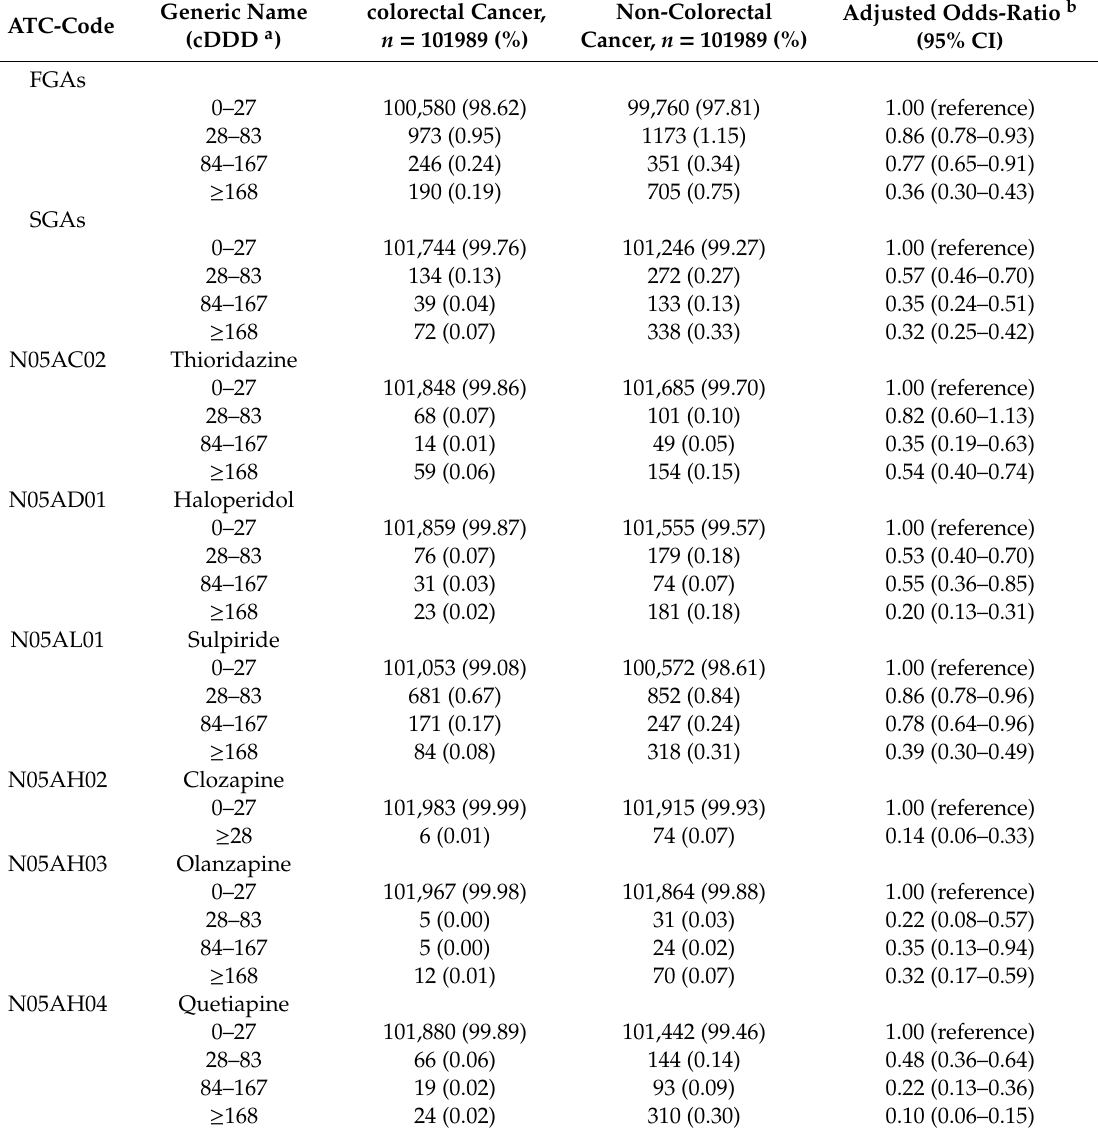
Table 3. Analysis of the association between the use of individual antipsychotics and the risk of colorectal cancer in a population-based case–control study a in Taiwan between 1997 and 2013.